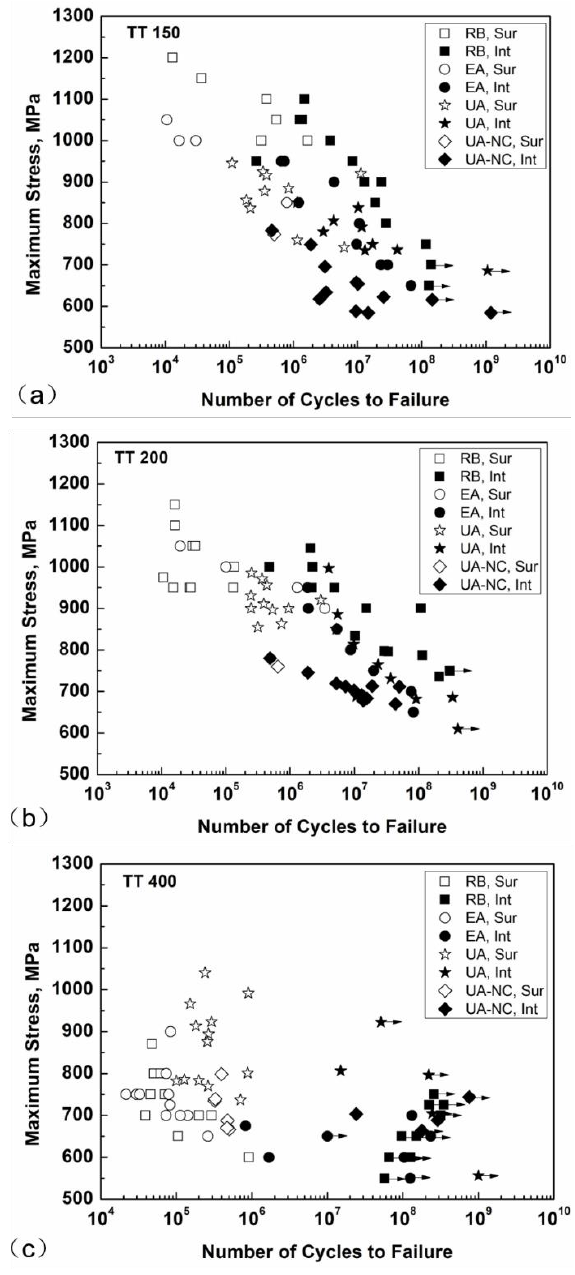
Figure 2. Fatigue stress–life (S-N) data for three material conditions: ( a ) TT 150; ( b ) TT 200; ( c ) TT 400. (Sur: crack surface initiation, Int: crack interior initiation, Symbol with arrow: no break).